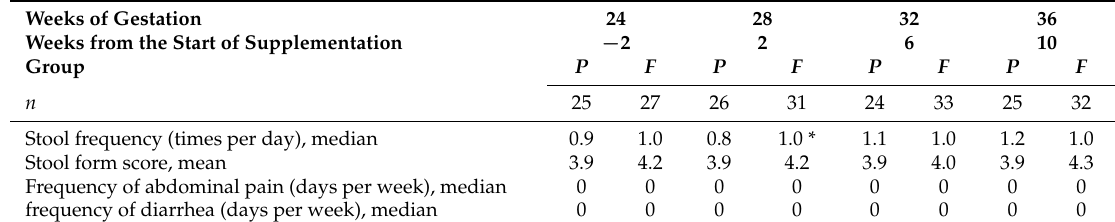
Table 3. Stool characteristics and adverse events recorded in pregnant women two weeks before the intervention and two, six, and 10 weeks after the